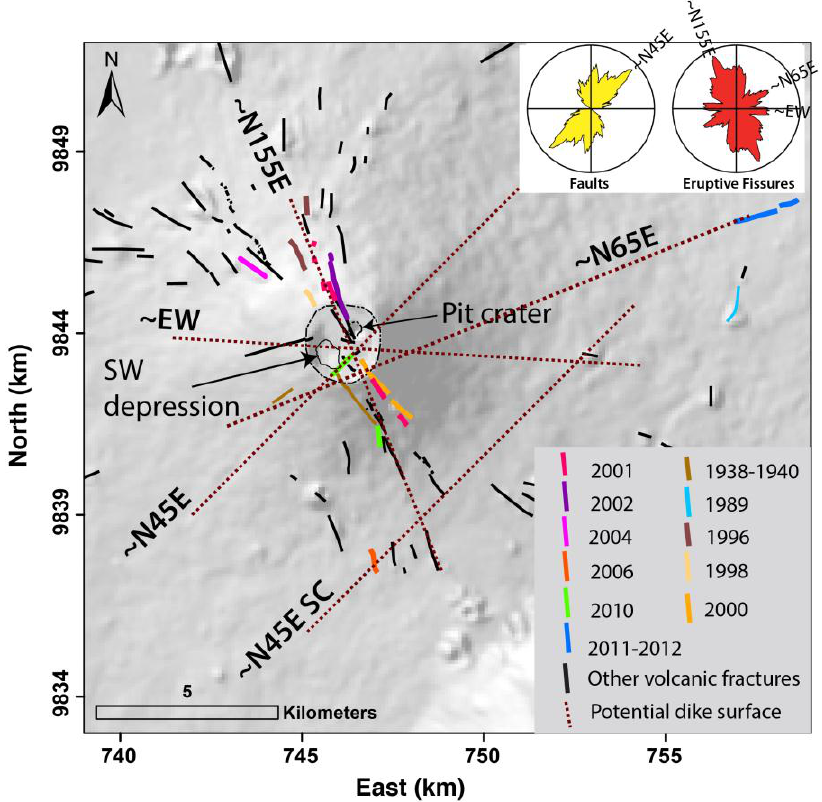
Figure 4. Close-up of the distribution of recent eruptive fissures at Nyamulagira. The potential dike surface orientations investigated in the normal stress analysis (Section 5.4) and shown in Figure 6 and Figure S3 are represented with brown dashed lines. SC stands for south of the